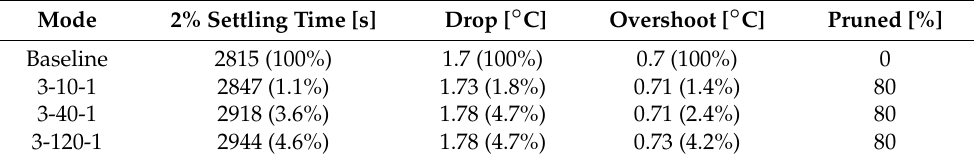
Table 8. Response characteristics comparison between the pruned models with various structures and the original pre-trained model. The overshoot value represents the maximum offset of the temperature variations in the rising